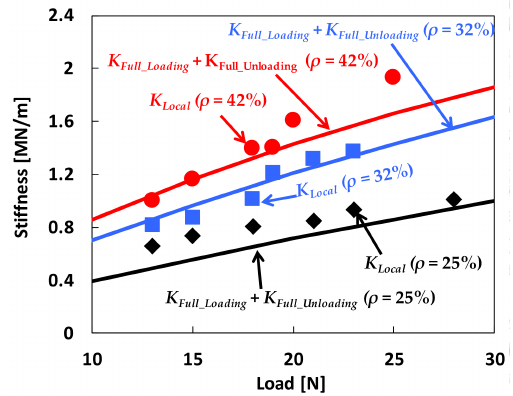
Figure 10. Comparison of structural stiffnesses from measurements of full and local hysteresis loops. Continuous solid lines and symbols denote K Full _ Loading + K Full _ Unloading and K Local ,